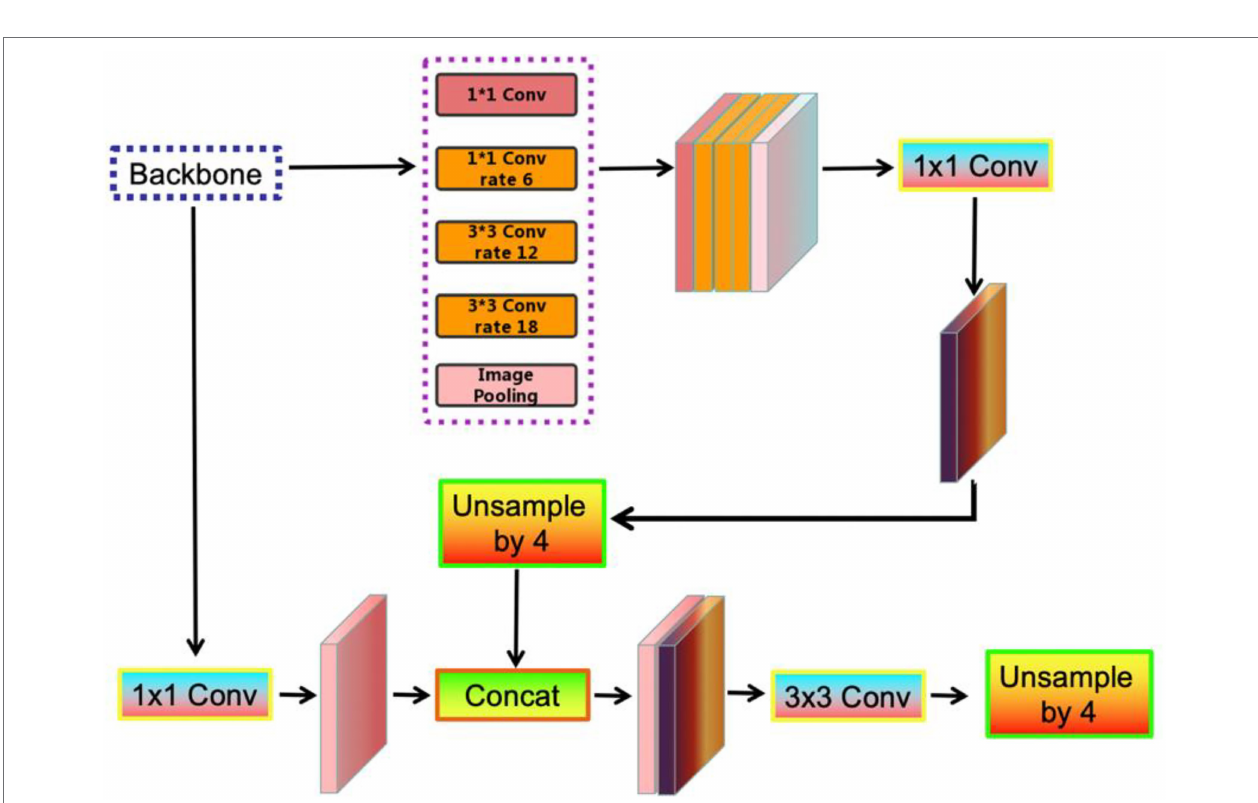
FIGURE 2 | The architecture of DeepLabV3+, where 1 × 1 Conv and 3 × 3 Conv denote the convolution with the kernel size of 1 × 1 and 3 × 3, respectively, Unsample denotes the bilinear upsampling operation, and Concat denotes the concatenation of